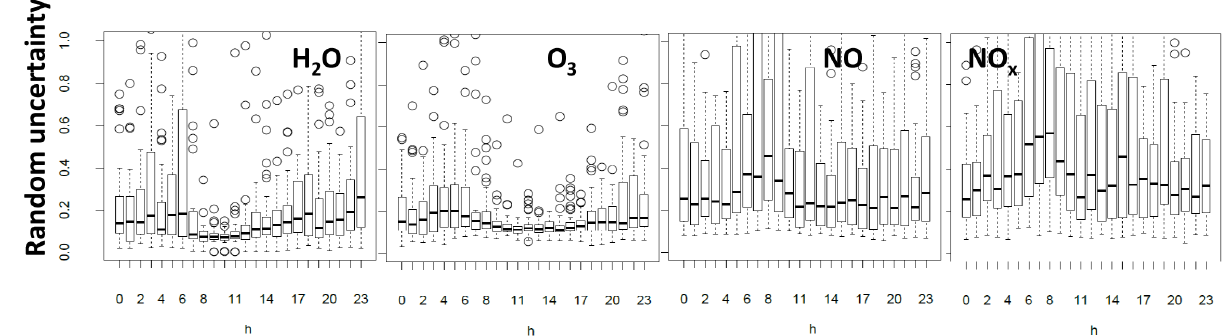
Figure 3. Daily variations of the ratio of the random uncertainty to the flux for H 2 O, O 3 , NO and NO x during August 2012 (15 August to 9 September). Black bars are medians, boxes show the interquartile, error bars show the minimum and maximum of the whisker and empty dots shows the